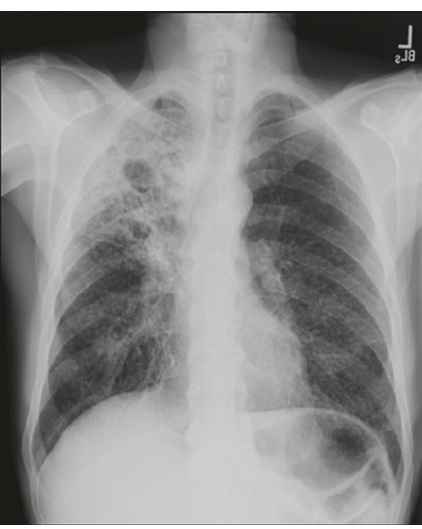
Figure 1: Chest X-ray showing cavitary opacity in the right upper lung field.